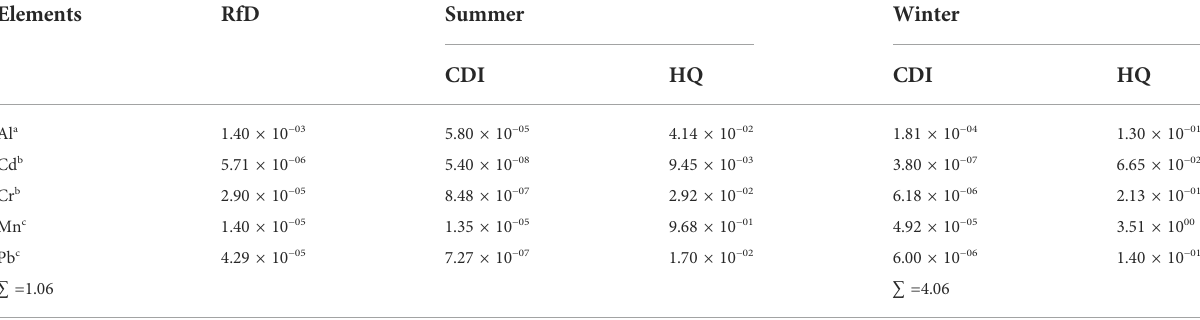
TABLE 3 Estimated non-cancer human health risks for scenarios during summer and winter.